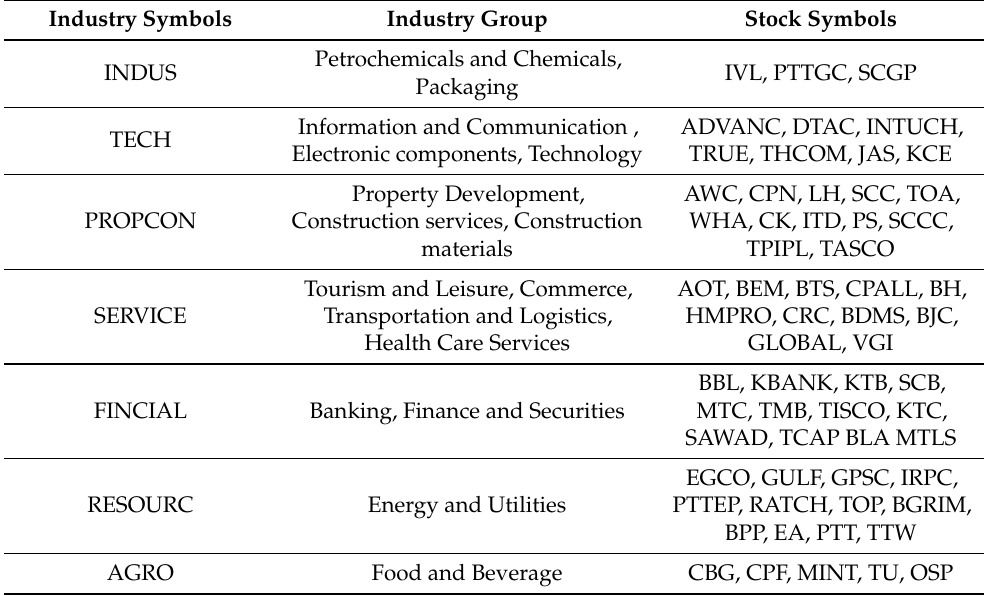
Table 5. Industry grouping for the SET50 index.